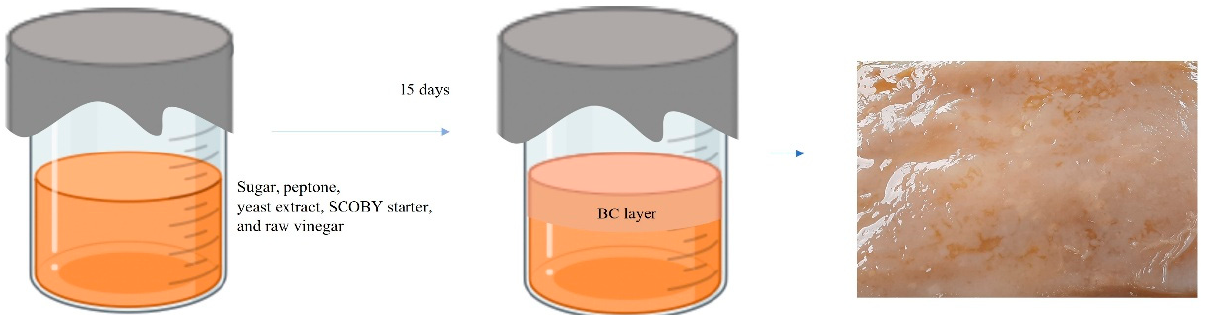
Figure 1. Infographic drawing of static culture of SCOBY BC.